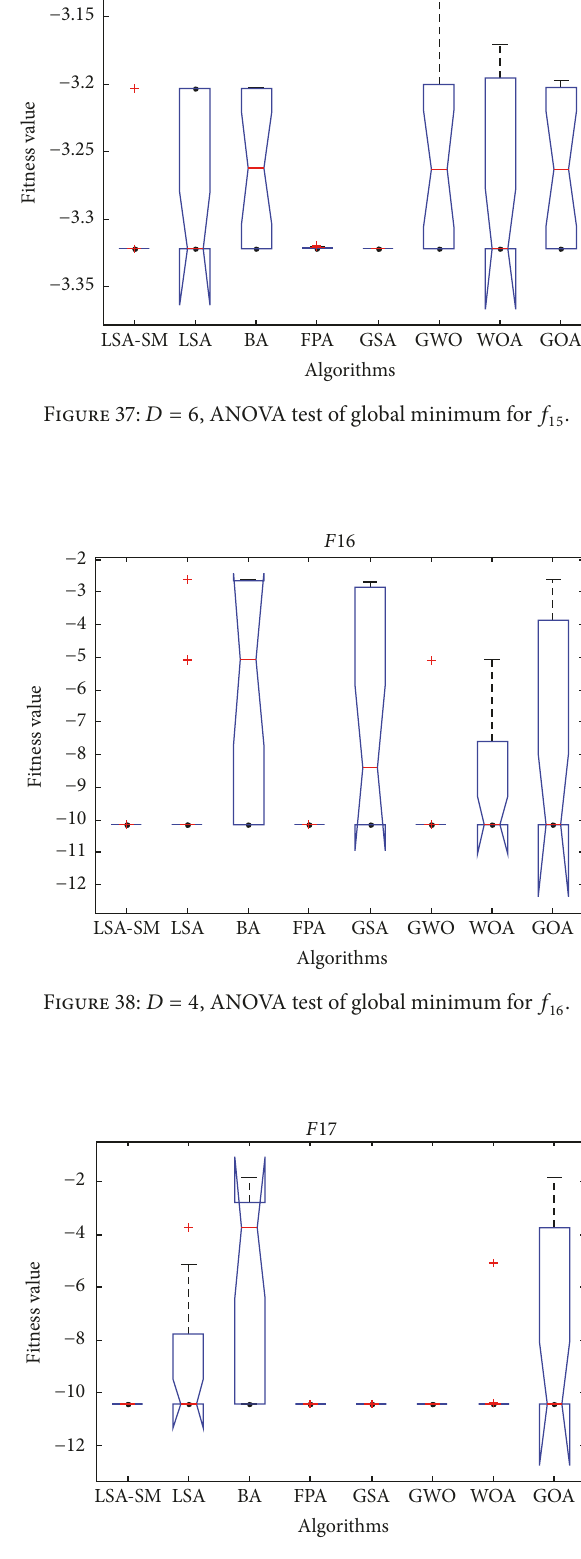
Figure 39: 𝐷 = 4 , ANOVA test of global minimum for 𝑓 17